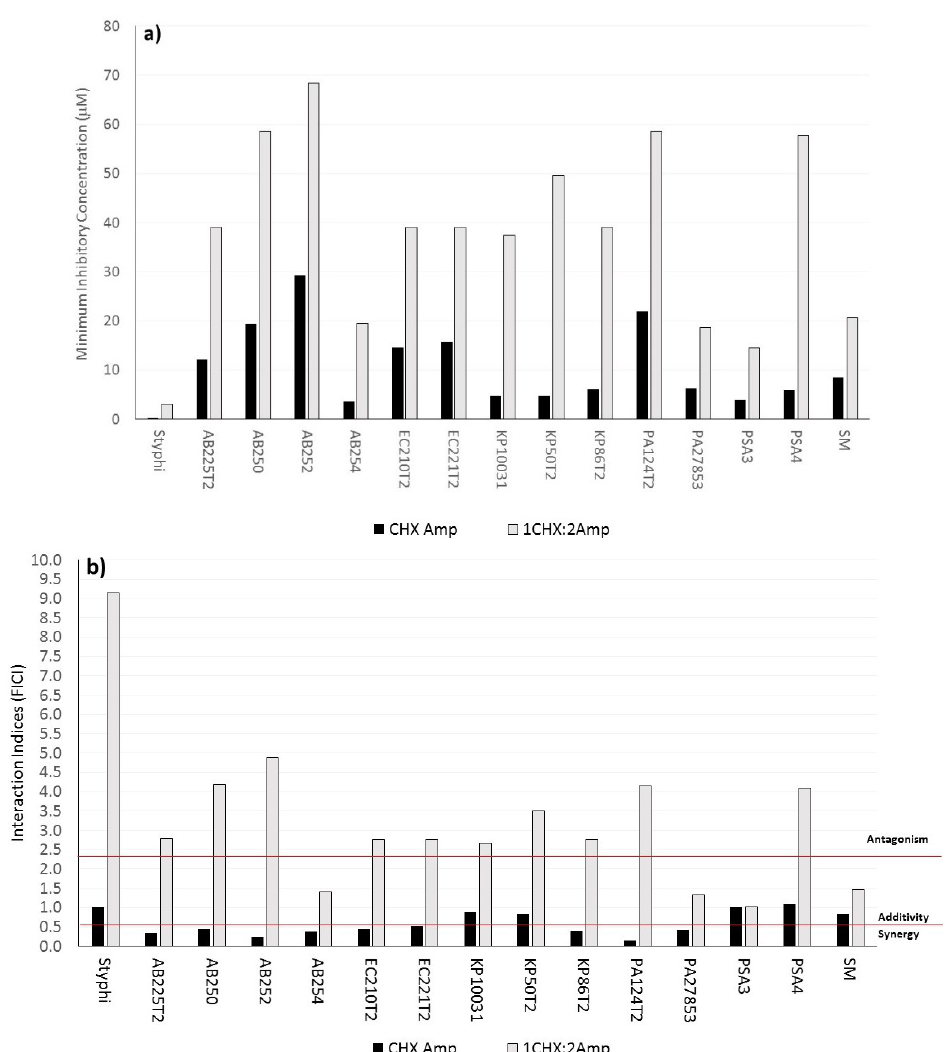
Figure 2. ( a ) MICs and ( b ) FICIs of chlorhexidine di-ampicillin (CHX Amp) GUMBOS and the unreacted stoichiometric equivalent (1 CHX: 2 Amp mixture) against 15 multi-drug-resistant Gram-negative